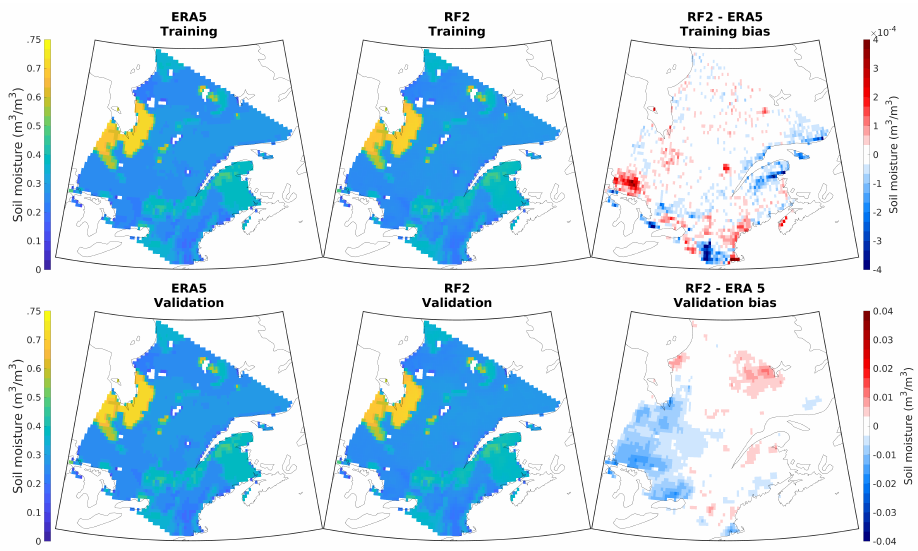
Figure 5. ERA5 ( left column) and RF2 simulated ( center column) SSM for training ( top panel) and validation ( bottom panel) periods and their biases ( right column).